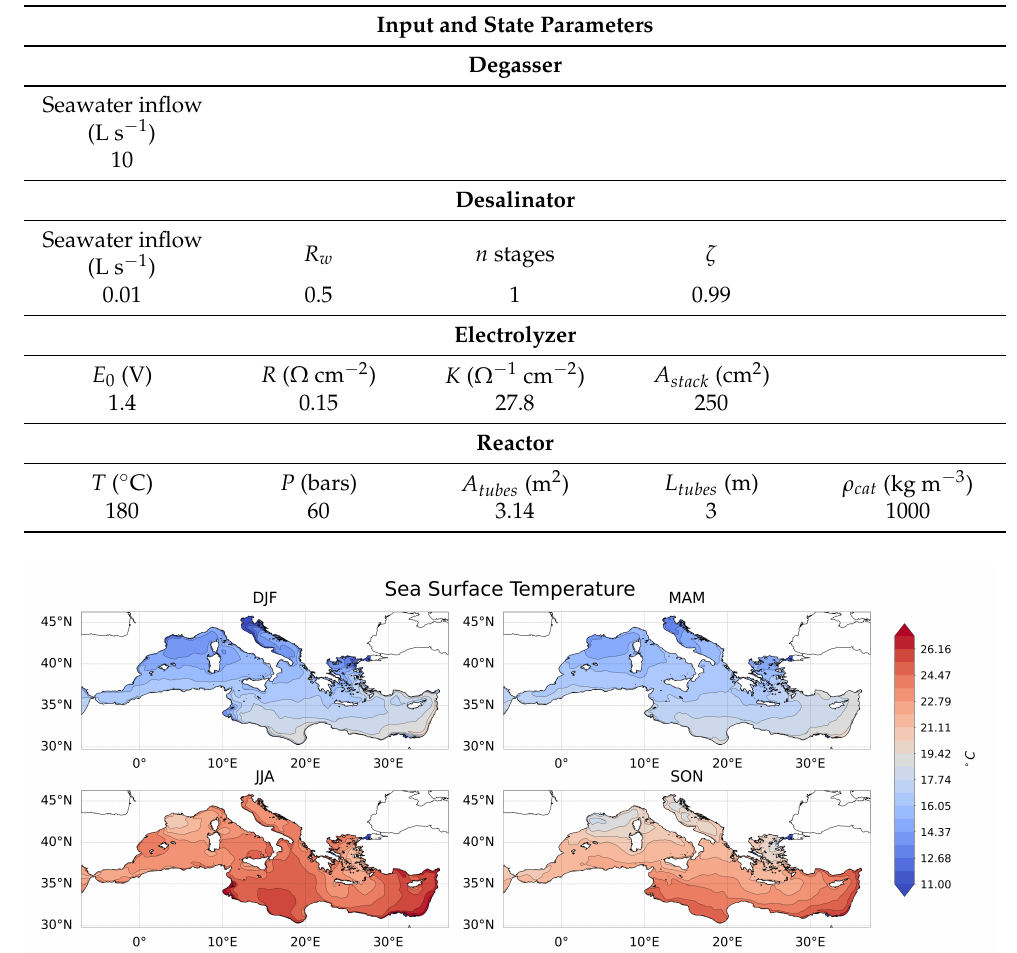
Table 1. These are parameters and their values that are used to numerically simulate a methanol island with pyseafuel , separated by subprocess (Figure 5). The electrolyzer parameters are common values in industry [60,72]. T and P for the reactor are within the range of previously tested temperatures and pressures for the methanol production from carbon dioxide hydrogenation [73]. Note: around 2 V minimum is typically required to generate the necessary current densities for electrolysis to occur [74].